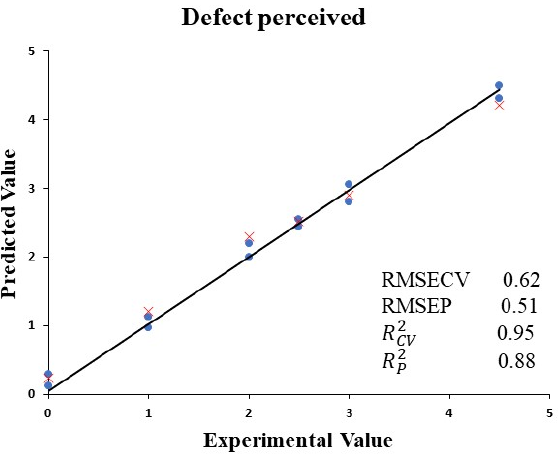
Figure 5. Experimental values against PLS cross-validation predictions ( • ) and validation set predictions ( × ) for VOO defects identified by panelists.